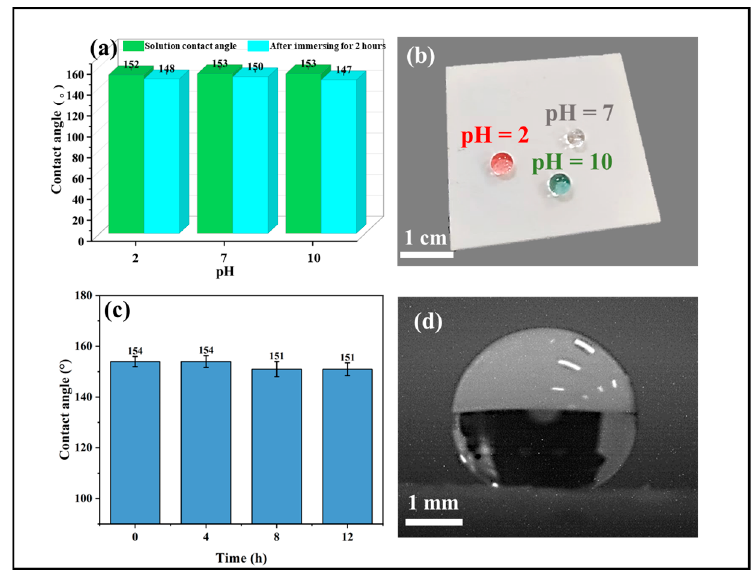
Figure 8. ( a ) Contact angle of different pH solutions on the superhydrophobic surface and the contact angle of the samples immersed in different chemical environments after 8 h; ( b ) Different pH solutions on the surface of the superhydrophobic samples; ( c ) Effect of UV irradiation time on the contact angle of the superhydrophobic surfaces; ( d ) The droplets on the surface of the samples after 12 h UV irradiation.